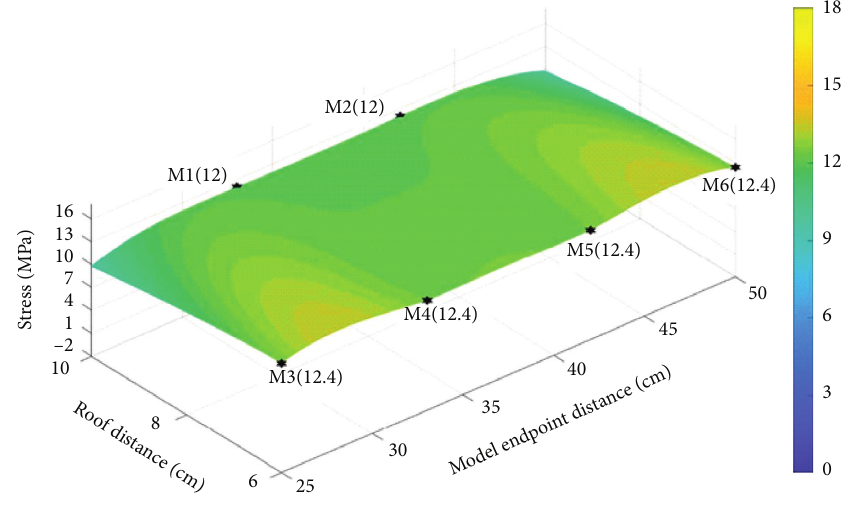
Figure 5: Initial stress